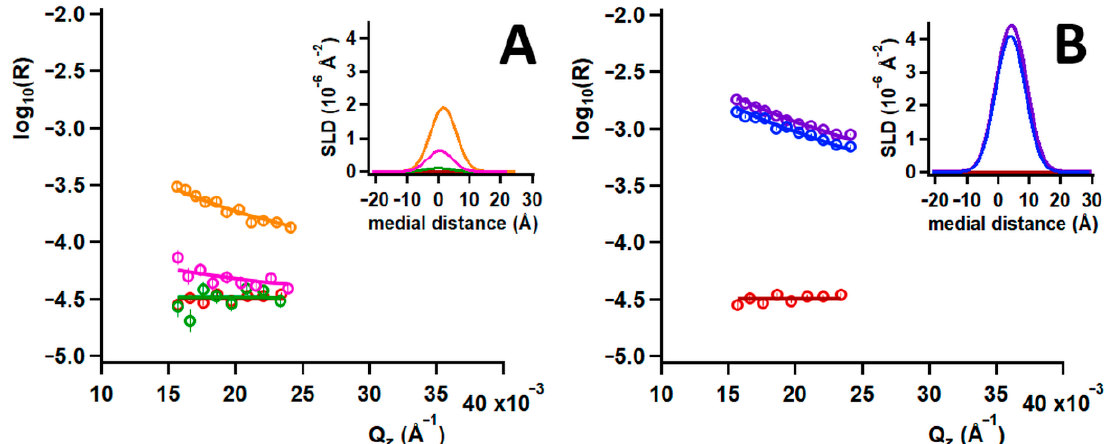
Figure 1. Neutron reflectivity data and model fits of ( A ) 60 mM cm-C 12 TAB solution in ACMW before (green) and after (orange) exposure to d-hexane vapor and ( B ) 60 mM d-C 12 TAB solution in ACMW before (purple) and after (blue) exposure to cm-hexane vapor; a bare ACMW measurement (red) is shown in both panels, and a measurement of ACMW infused with d-hexane (to preclude depletion effects) after exposure to d-hexane (pink) is shown in panel A for reference. SLD profiles are shown as insets.